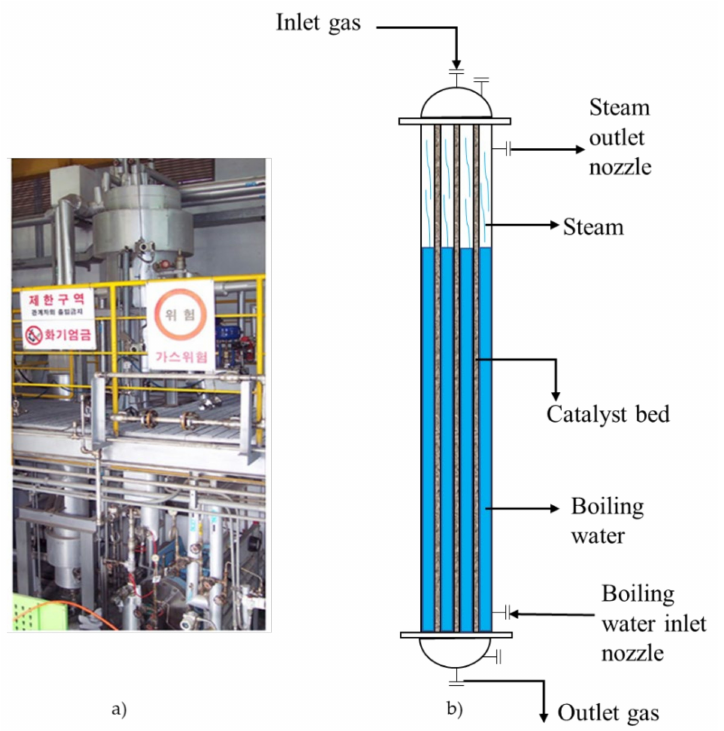
Figure 1. ( a ) The pilot fixed bed reactor; ( b ) reactor